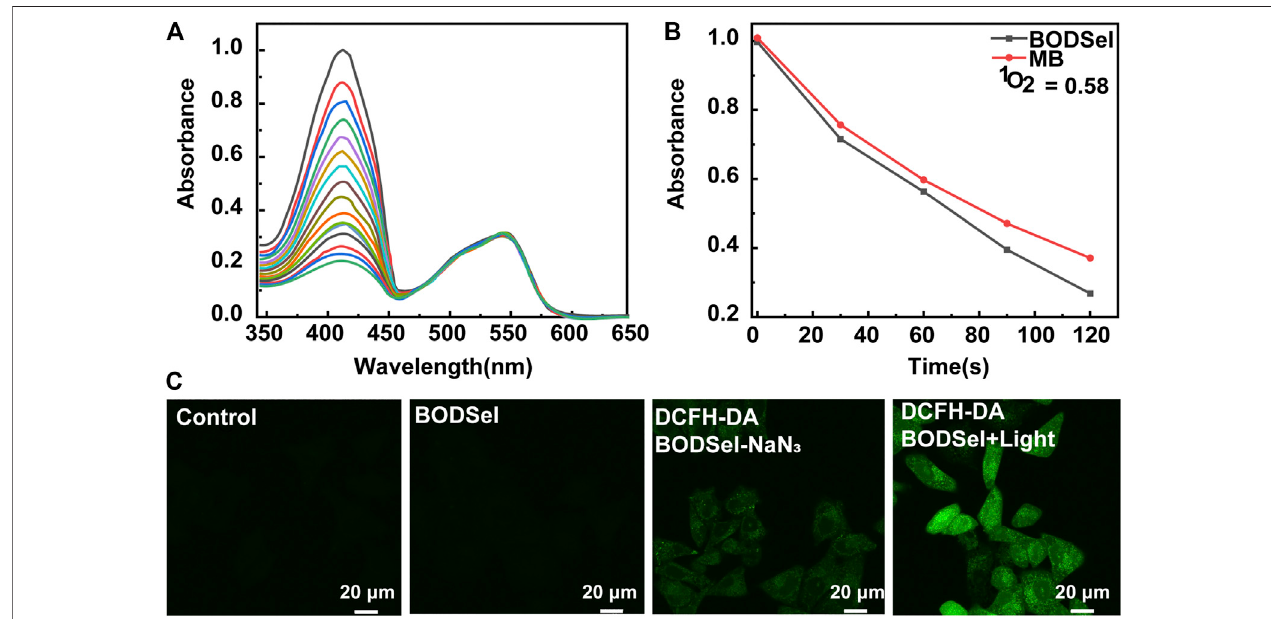
FIGURE3|(A) Time-dependentphotodegradationofDPBFwithBODSeIinDCM. (B) DPBFdegradationratesatdifferenttimepoints(thecommercialPS;MBwas used as areference). (C) Fluorescence imaging of ROSdetection with/without BODSeI(1 μ M) and lightirradiation (550 nm, 20 mw/cm 2 , 10 min)in MCF-7 cells [DCFH- DA (10 μ M) was used as the fl uorescence detector, and 50 μ M NaN 3 was used as the single oxygen